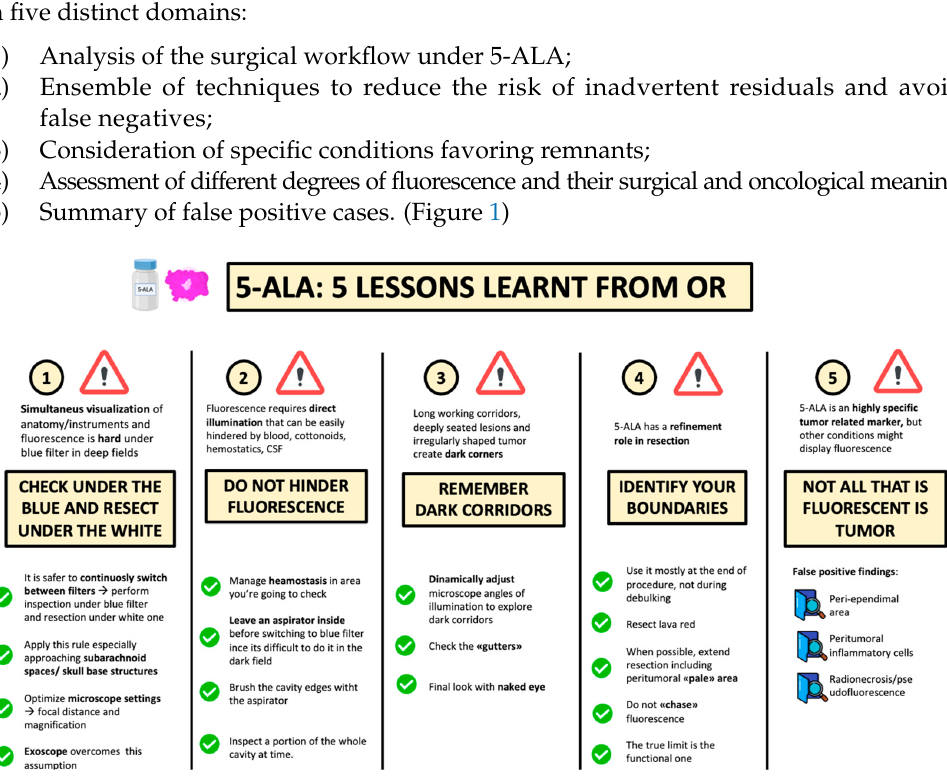
Figure 1. Pictorial summary of our